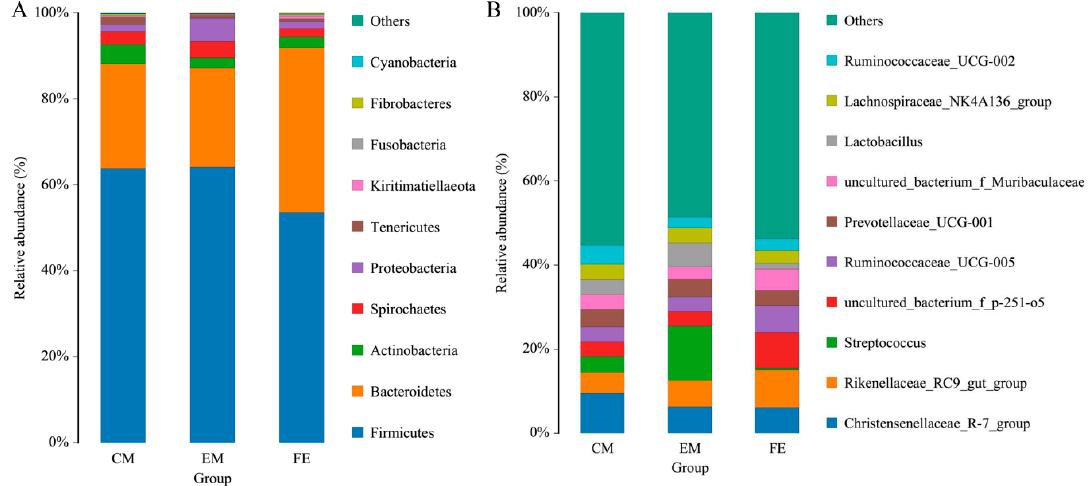
Figure 2. Histogram of the top 10 phylum ( A ) and genus ( B ) in each